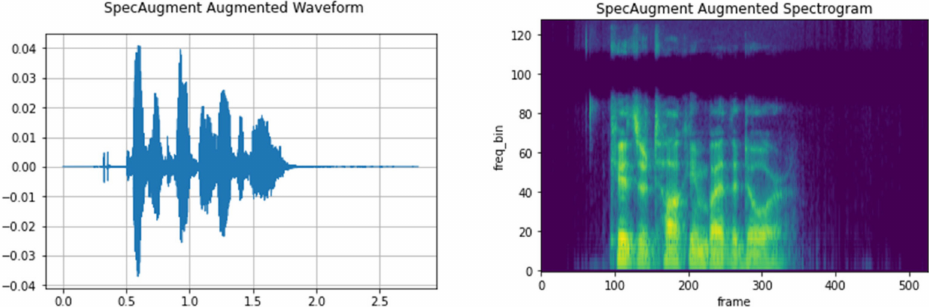
Figure 3. Waveform and Spectrogram representations of an SpecAugment augmented